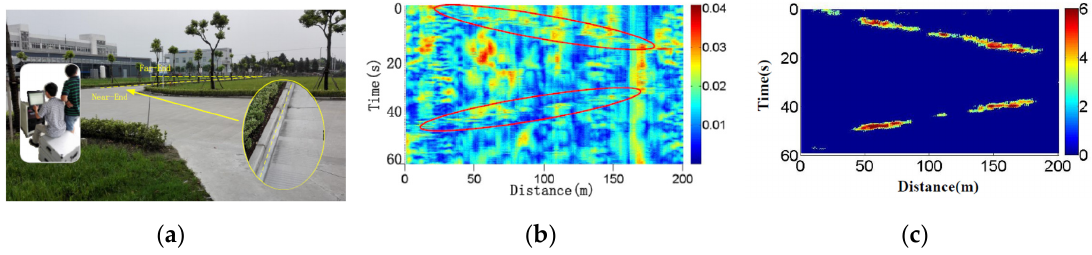
Figure 20. Vehicle detection in a test park. ( a ) Field test setup; ( b ) Raw waterfall pattern; ( c ) Processed waterfall pattern. Reproduced with permission from our previous paper [90], published by Optical Society of America, 2015.